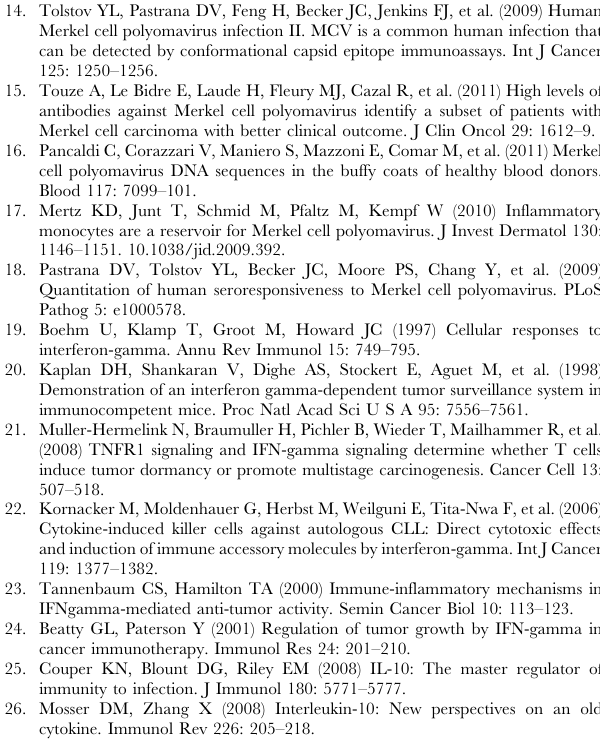
Note S1 Antibody versus cytokine responses in